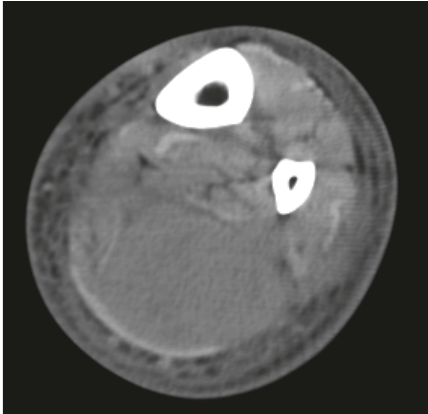
Figure 6: Axial contrast enhanced CT image of the 55-year-old man from case 2 showing diffuse enlargement of the soleus muscle which is homogenously iso- to slightly hypodense relative to adjacent muscle. Note the skin thickening and subcutaneous fat stranding, which can also be seen in